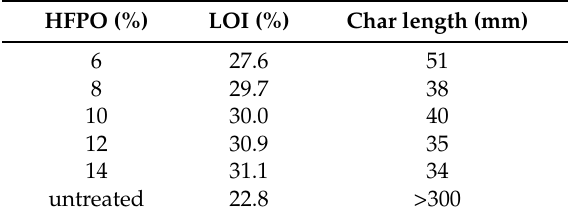
Table 5. The LOI and vertical burning flammability of the Nomex ® /cotton blend fabric treated with 3% BTCA and HFPO at different concentrations, cured at 170 °C for 3 min and finally subjected to one home laundering cycle.